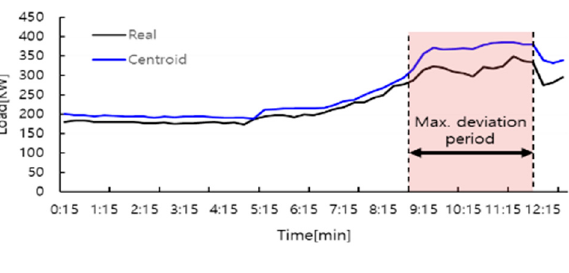
Figure 6. 22 June 2017 demand load profile.